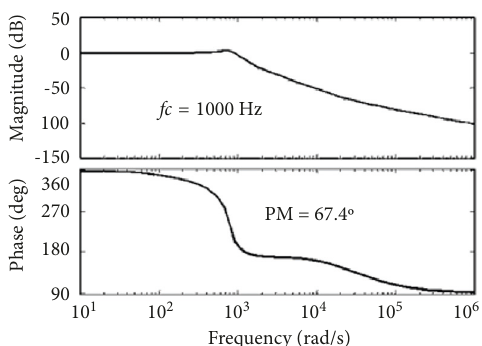
Figure 9: Bode diagram of closed-loop control for the proposed